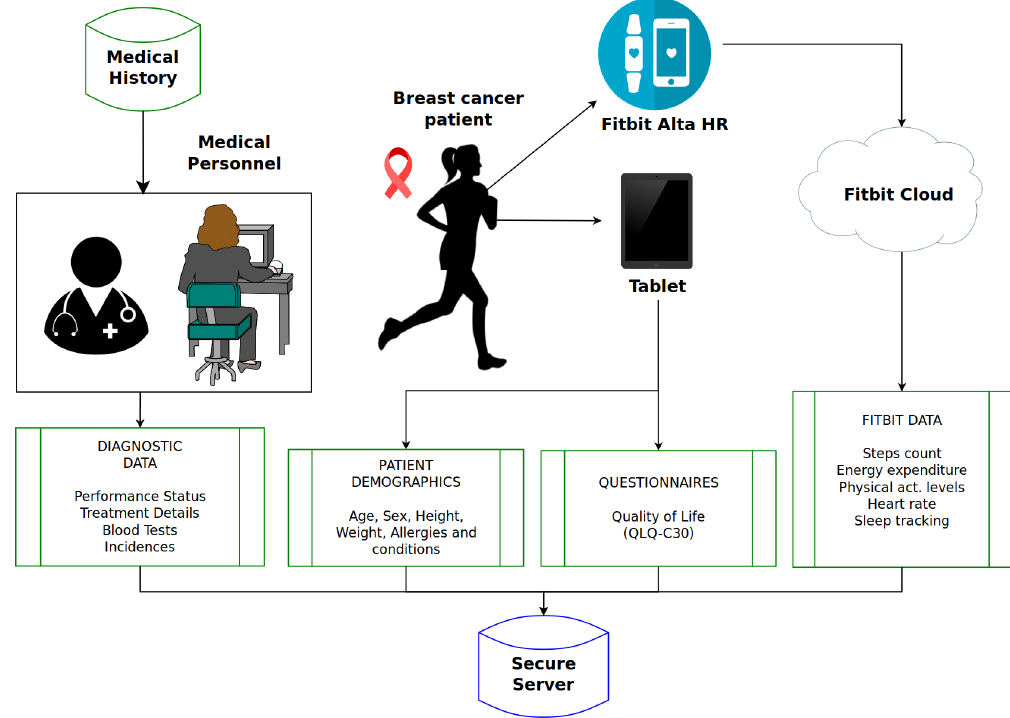
Figure 1. System